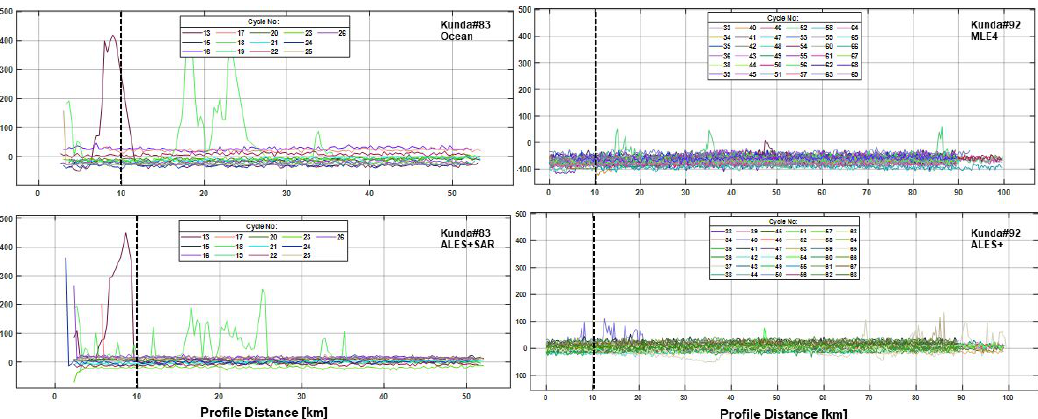
Figure 6: Discrepancies SSH diff per each cycle in Kunda-083 S3A (left hand side) and Kunda-092 JA3 (right hand side) using Ocean and MLE4 (top) and ALES+ SAR and ALES+ (bottom) retrackers. The zero value in the horizontal axis denotes the location of the coastline.